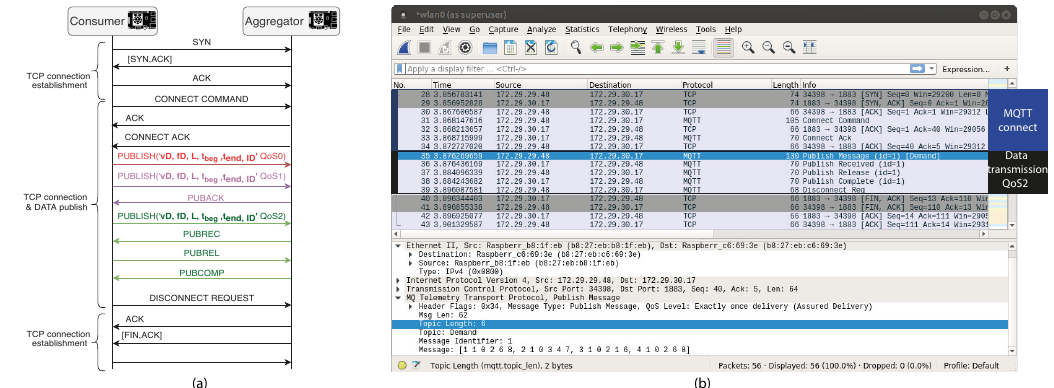
Figure 12. MQTT handshake ( a ) and capture of the communication with QoS Level 2 ( b ), insecure, without TLS, between the consumer and aggregator . Application data fit in a single MQTT datagram, which was sent clear over TCP/IP.